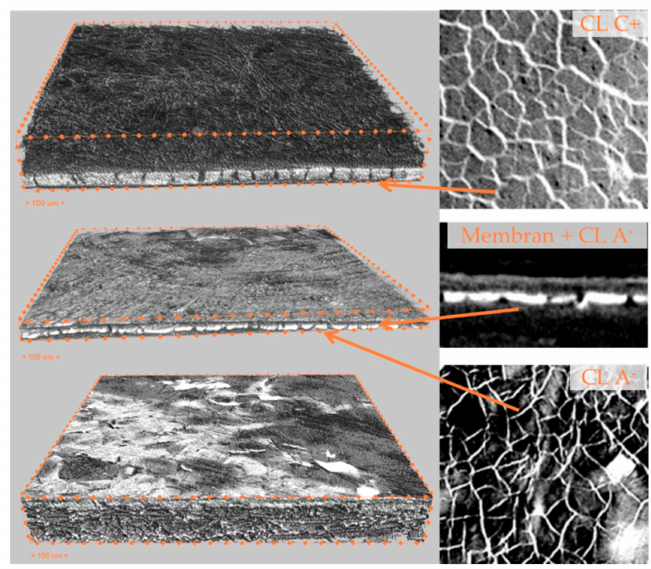
Figure 9. Reconstructed 3D images (CTVox) of the complete MEA FMT-C EoT. Zoomed in areas are reconstructed 2D / 3D images (DataViewer) of single layers (GDL, Membran, CL). Table 5. Average layer thicknesses of FMT-B BoL and FMT-C determined by DataViewer.